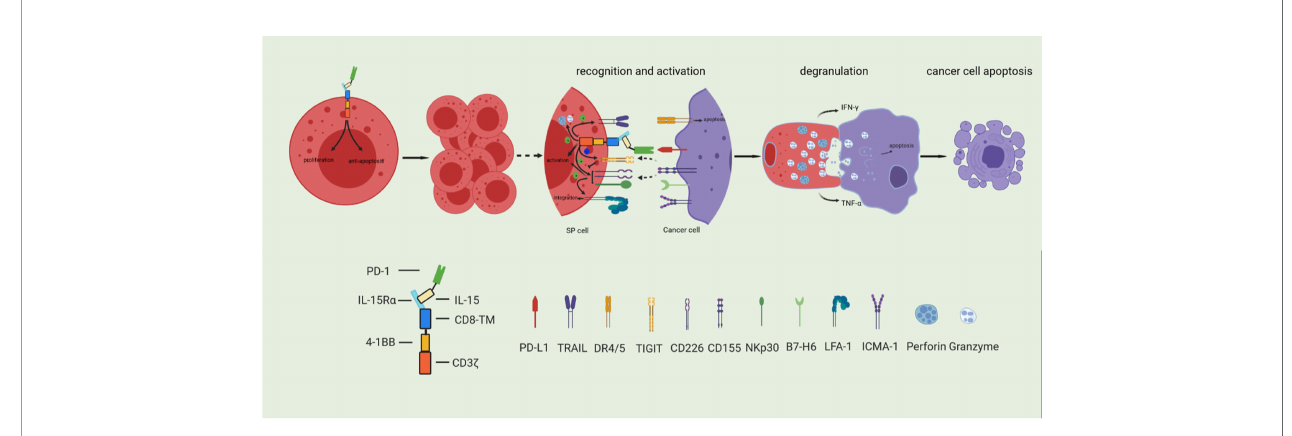
FIGURE 8 | Based on the synergy and comprehensive effects of special CAR structure, SP cells have enhanced proliferative and anti-apoptosis ability, and comprehensively